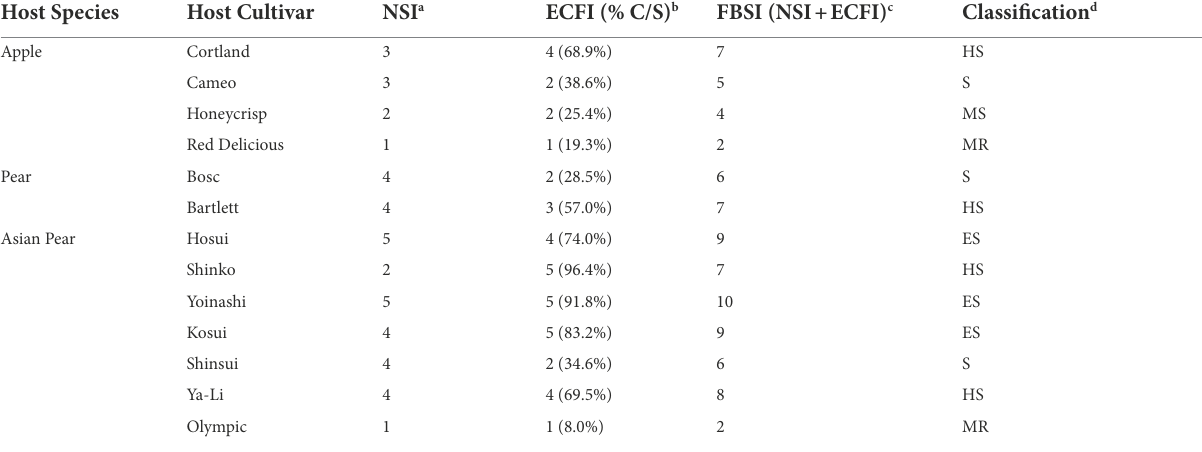
TABLE 1 Fire blight resistance classification of the host species and cultivars used in this study.